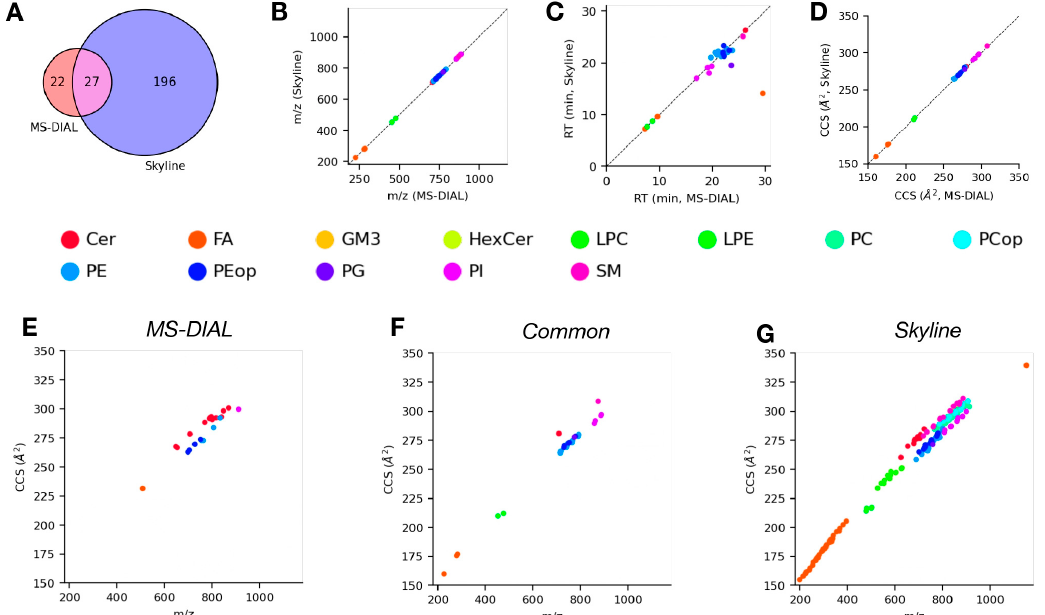
Figure 3. Comparison of lipid identifications from analysis of negative mode LC-DTIMS-MS/MS lipidomics data using Skyline and MS-DIAL. ( A ) Venn diagram of lipids identified using either software. ( B – D ) Comparisons of m / z ( B ), retention time ( C ), and CCS ( D ) values from MS-DIAL vs. Skyline for common lipid identi fi cations from both tools, points colored according to lipid class. ( E , F ) CCS trend lines or IMS-MS conformational space of lipids identi fi ed by MS-DIAL ( E ), Skyline ( G ), or both tools ( F ), points colored according to lipid class.